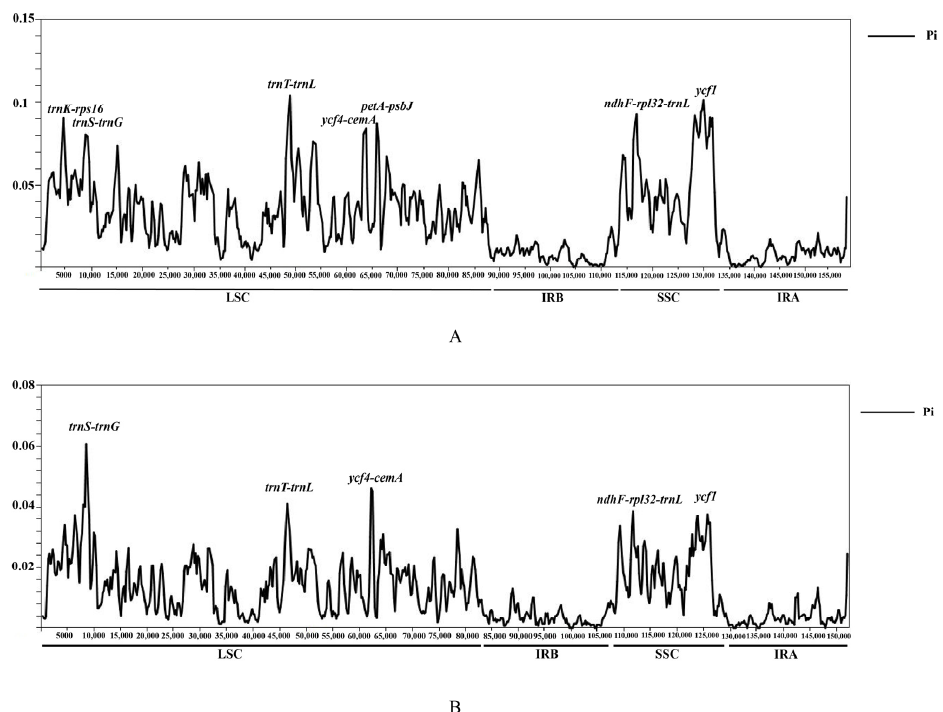
Figure 4. Comparative analysis of the nucleotide polymorphism (Pi) values among the cp genomes of Saxifraga . ( A ) Pi values calculated as all the seven Saxifraga species were taken into account. ( B ) Pi values calculated as five species in Sect. Ciliatae was selected